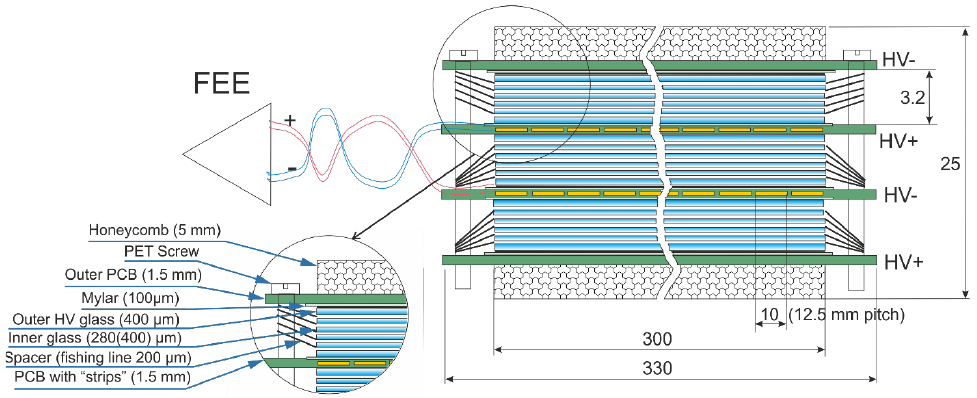
Figure 3. Scheme of the triple-stack MRPC for ToF